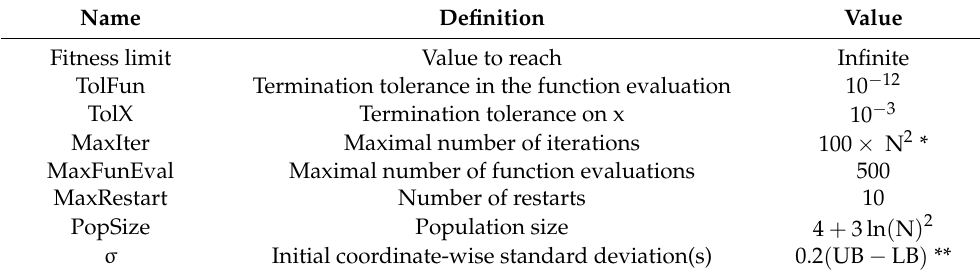
Table 1. Parameter values used for the CMA-ES